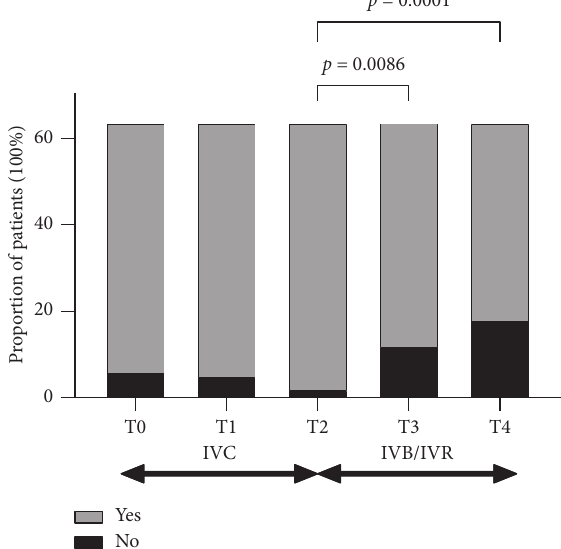
Figure 5: Changes of the mean cPEDH in eyes with persistent nAMD. cPEDH did not change statistically significantly during the treatment of IVC. But it significantly reduced after switching to IVR or IVB from 169.3 ± 230.6 μ m to 130.5 ± 180.2 μ m at T3 and 114.6 ± 142.6 μ m at T4. The mean change of cPEDH from T2 was significantly larger in IVR subgroup than in IVB subgroup at both T3 ( p � 0 . 033) and T4 ( p � 0 . 010). cPEDH, PED height at foveal center; PED, pigmented epithelial detachment; IVC, intravitreal injections of conbercept; IVB, intravitreal injection of bevacizumab; IVR, intravitreal injection of ranibizumab; T0, baseline visit; T1, 1 month after the first ICV; T2, 1 month after 3 monthly IVC; T3, 1 month after the first IVR or IVB; T4, 1 month after the last IVR or IVB.